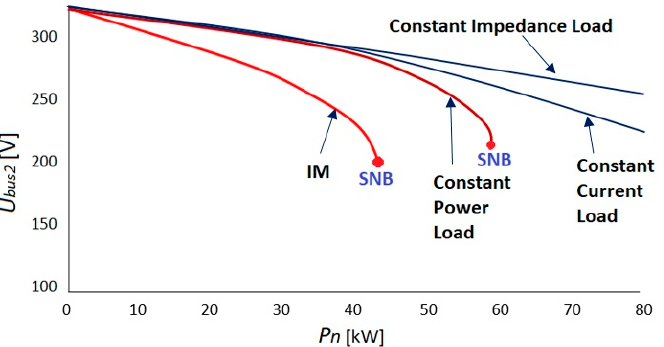
Figure 7. Saddle nodal bifurcation (SNB) phenomenon for the PV curve with increasing loads